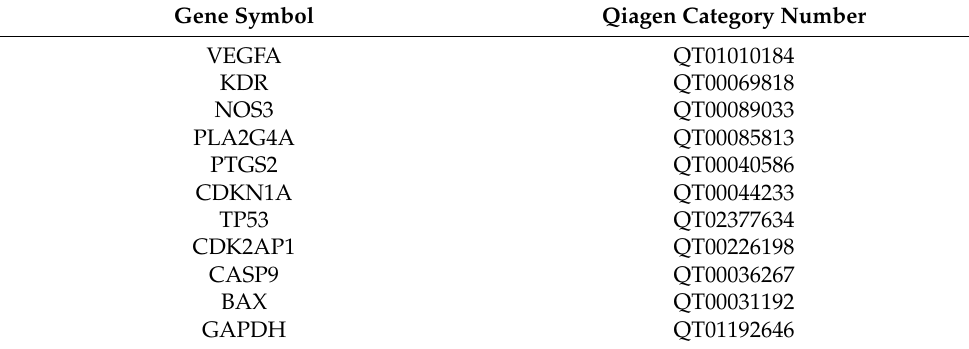
Gene Symbol Qiagen Category